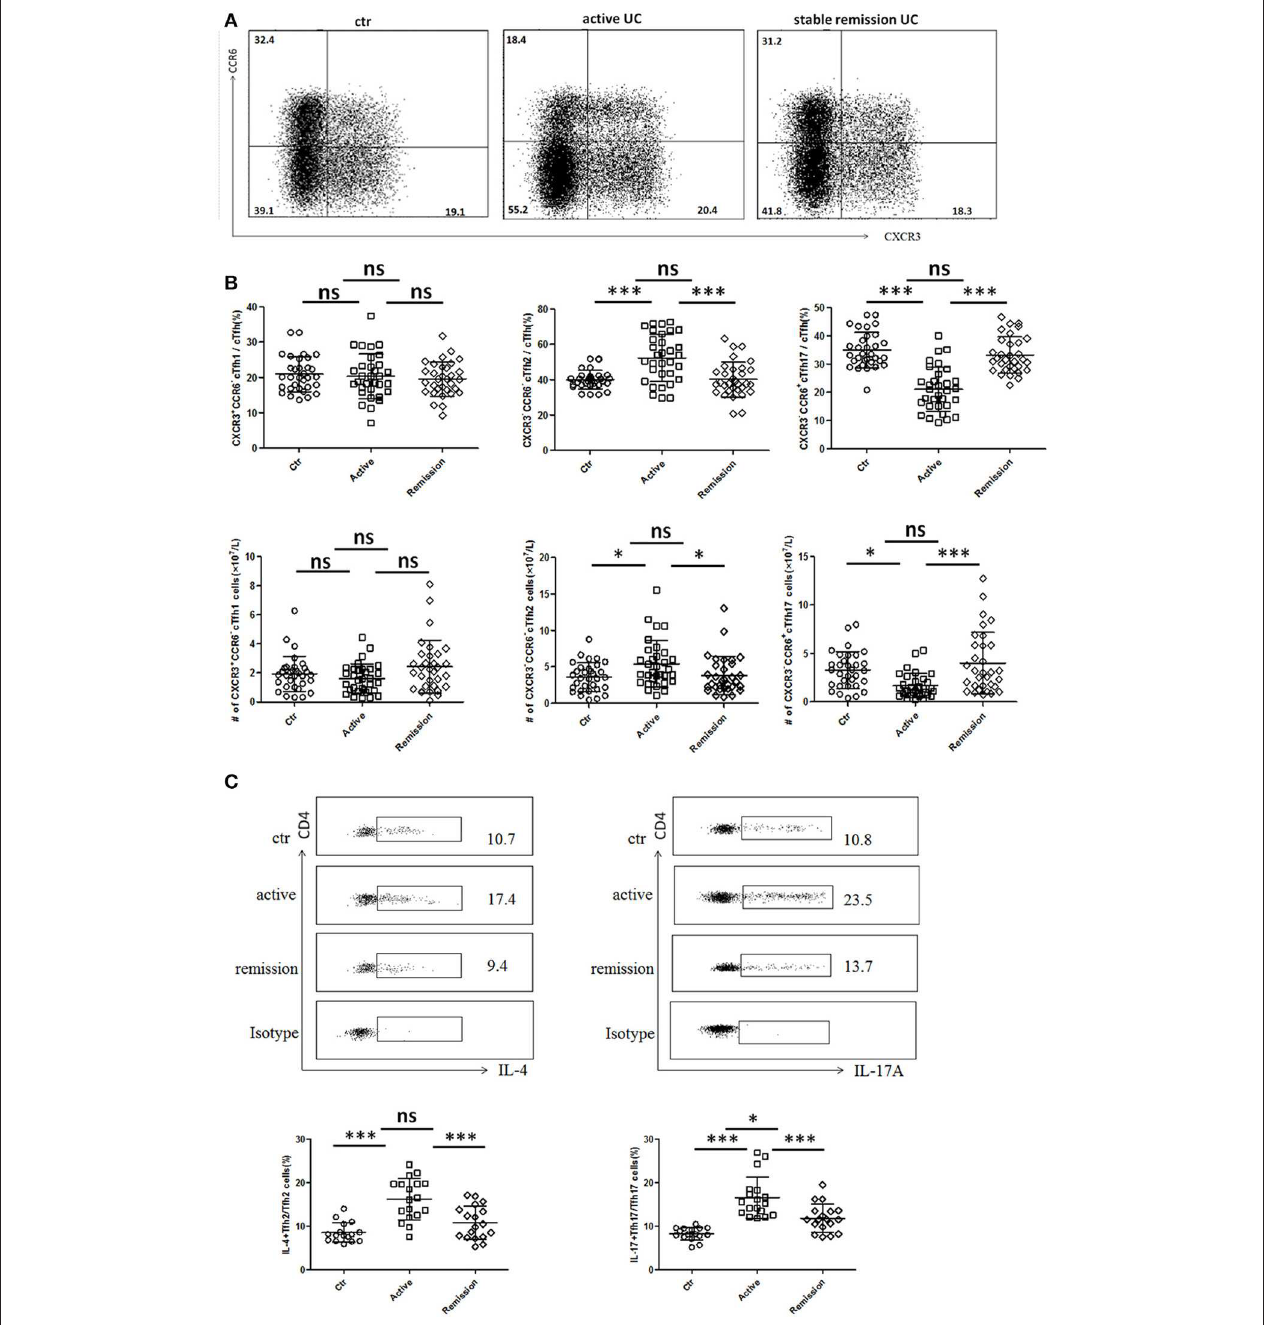
FIGURE 2 | Flow cytometry analysis of TFH subset levels and cytokine secretion in UC patients. (A,B) Peripheral blood from active UC patients ( n = 32), stable remission UC patients ( n = 32), and HC ( n = 32) was collected and TFH subsets were analyzed. TFH1, TFH2, and TFH17 were defined as follows: TFH1 (CD3 + CD4 + CXCR5 + FoxP3 − CXCR3 + CCR6 − ), TFH2 (CD3 + CD4 + CXCR5 + FoxP3 − CXCR3 − CCR6 − ), and TFH17 (CD3 + CD4 + CXCR5 + FoxP3 − CXCR3 − CCR6 + ). (A) Representative cytometry strategy for detection of CXCR3 and CCR6 expressions in CD3 + CD4 + CXCR5 + FoxP3 − T cells. Numbers indicate the percentage of cells in each quadrant. (B) The comparison of average percentage (up) and absolute number per liter (bottom) of TFH1, TFH2, TFH17 subsets among active UC patients, patients in stable remission UC and HC. (C) Peripheral blood from active UC patients ( n = 18), stable remission UC patients ( n = 18) and HC ( n = 16) were incubated with PMA, ionomycin and BFA for 5h and cytokines within TFH subsets were analyzed by intracellular staining. Representative dot plots of IL-4 secretion levels in TFH2 subset and IL-17A secretion levels in TFH17 subset. Numbers show the percentages of IL-4 + cells among TFH2 and IL-17A + cells among TFH17 lymphocytes (up). IL-4 + cell percentages in TFH2 and IL-17A + cells among TFH17 were compared (bottom), respectively. All Symbols represent individuals and bars show the mean ± SD. * p < 0.05; *** p < 0.001; ns, not significant.